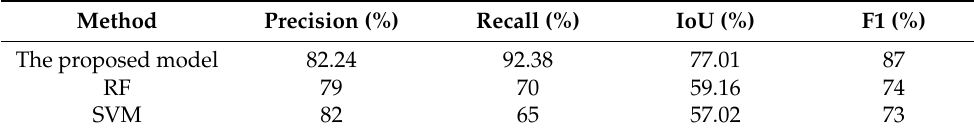
Table 3. The comparison with the accuracy of traditional classification methods.